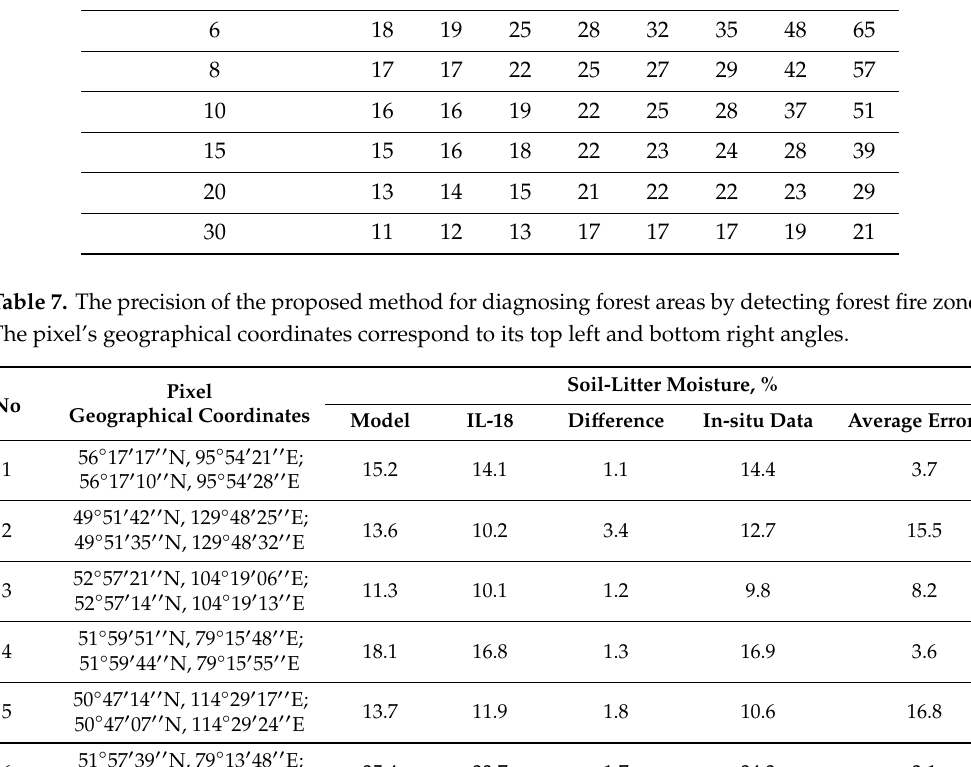
Days after Rainfall